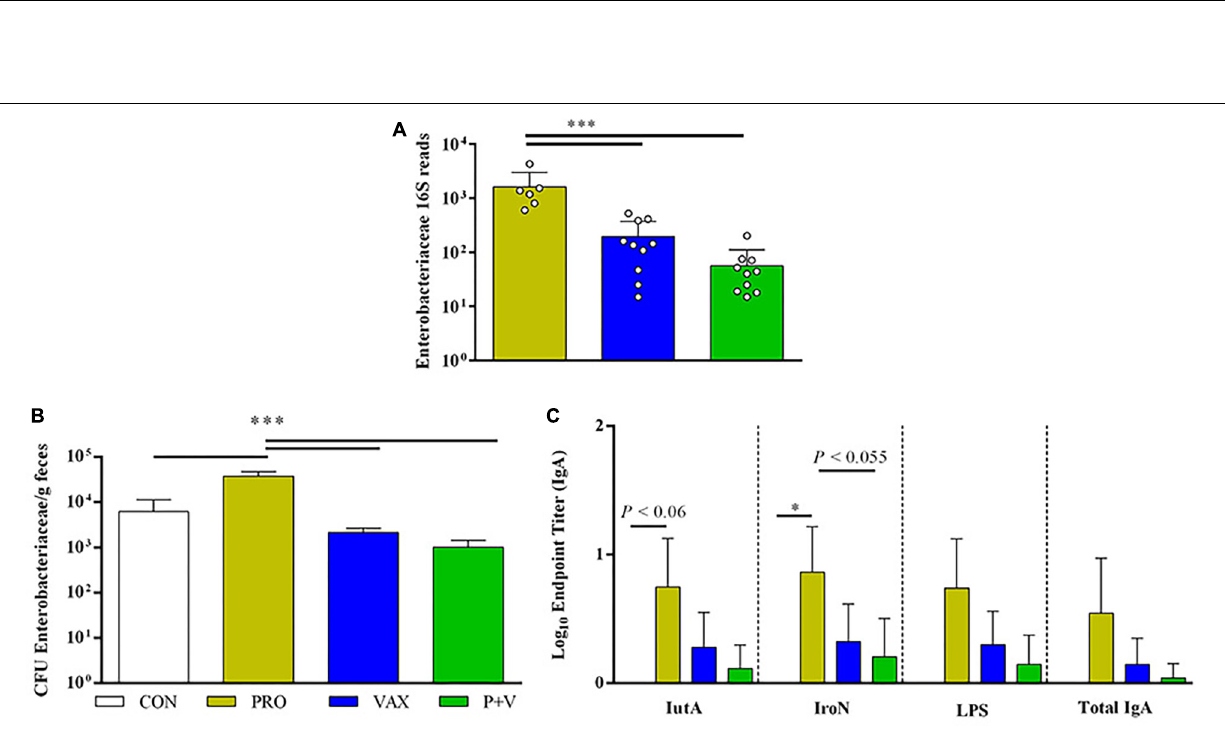
Frontiers in Microbiology |